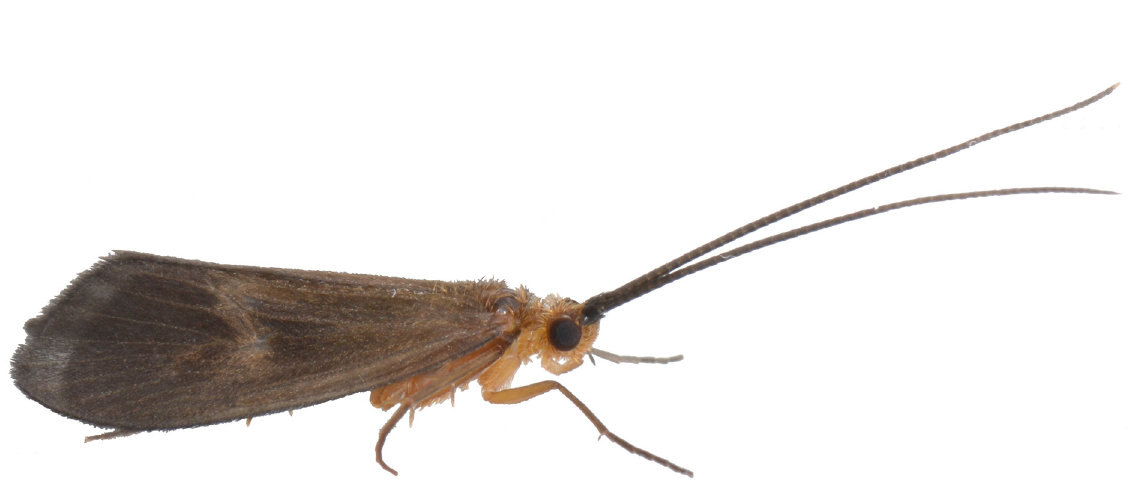
Fig. 3. Silvatares laetae Ngirinshuti & Johanson sp. nov., ♂,